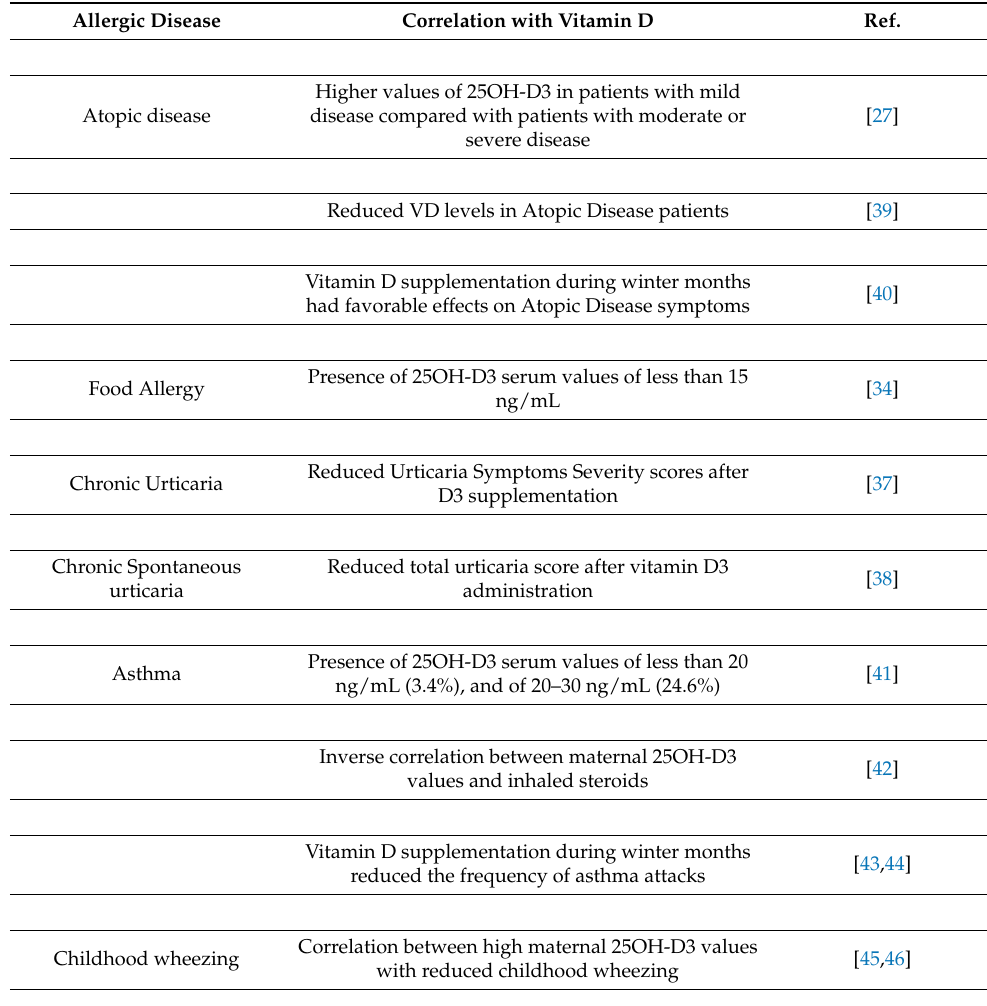
Table 1. Effects of Vitamin D on